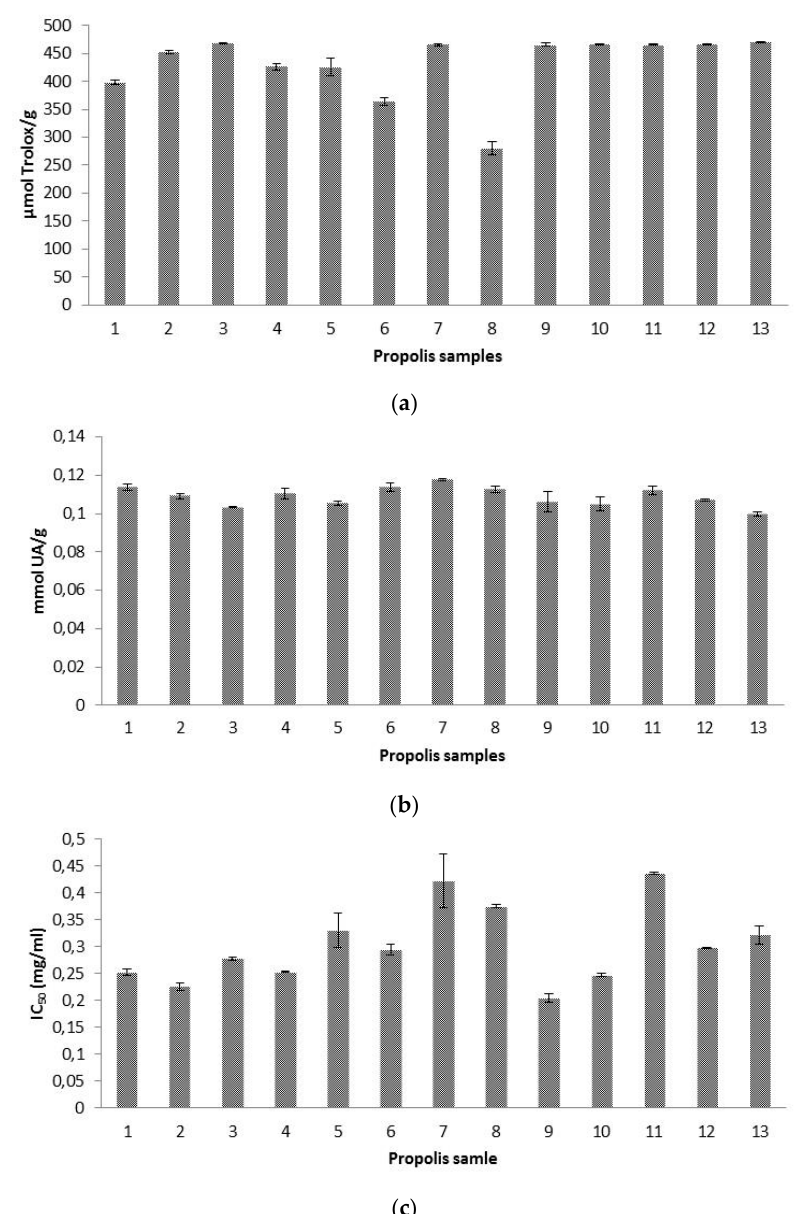
Figure 2. Mean values ( n = 3) of: ( a ) Trolox equivalent antioxidant capacity (TEAC) expressed as μ mol Trolox/g of propolis, ( b ) radical ‐ scavenging activity on hydroxyl radicals expressed as mmol uric acid (UA)/g of propolis, and ( c ) radical ‐ scavenging effect on superoxide radicals expressed as half maximal inhibitory concentration (IC 50 ) (mg/mL). Error bars represent the standard deviation for each data point.